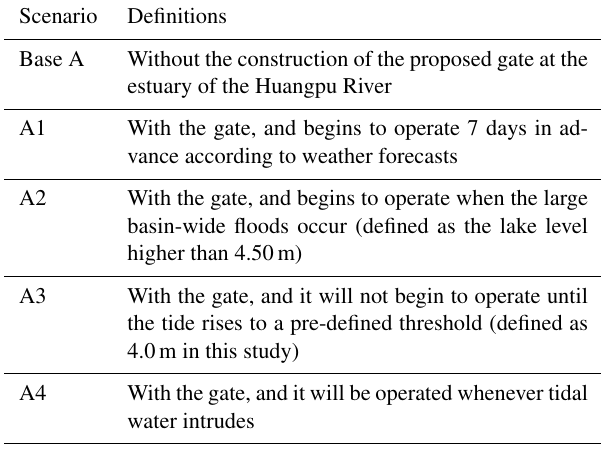
Table 1. The definitions of the five different scenarios considered in this